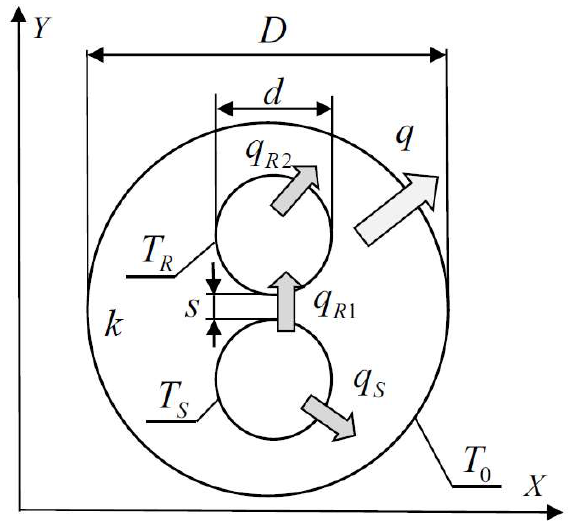
Figure 1. Geometry and boundary conditions.